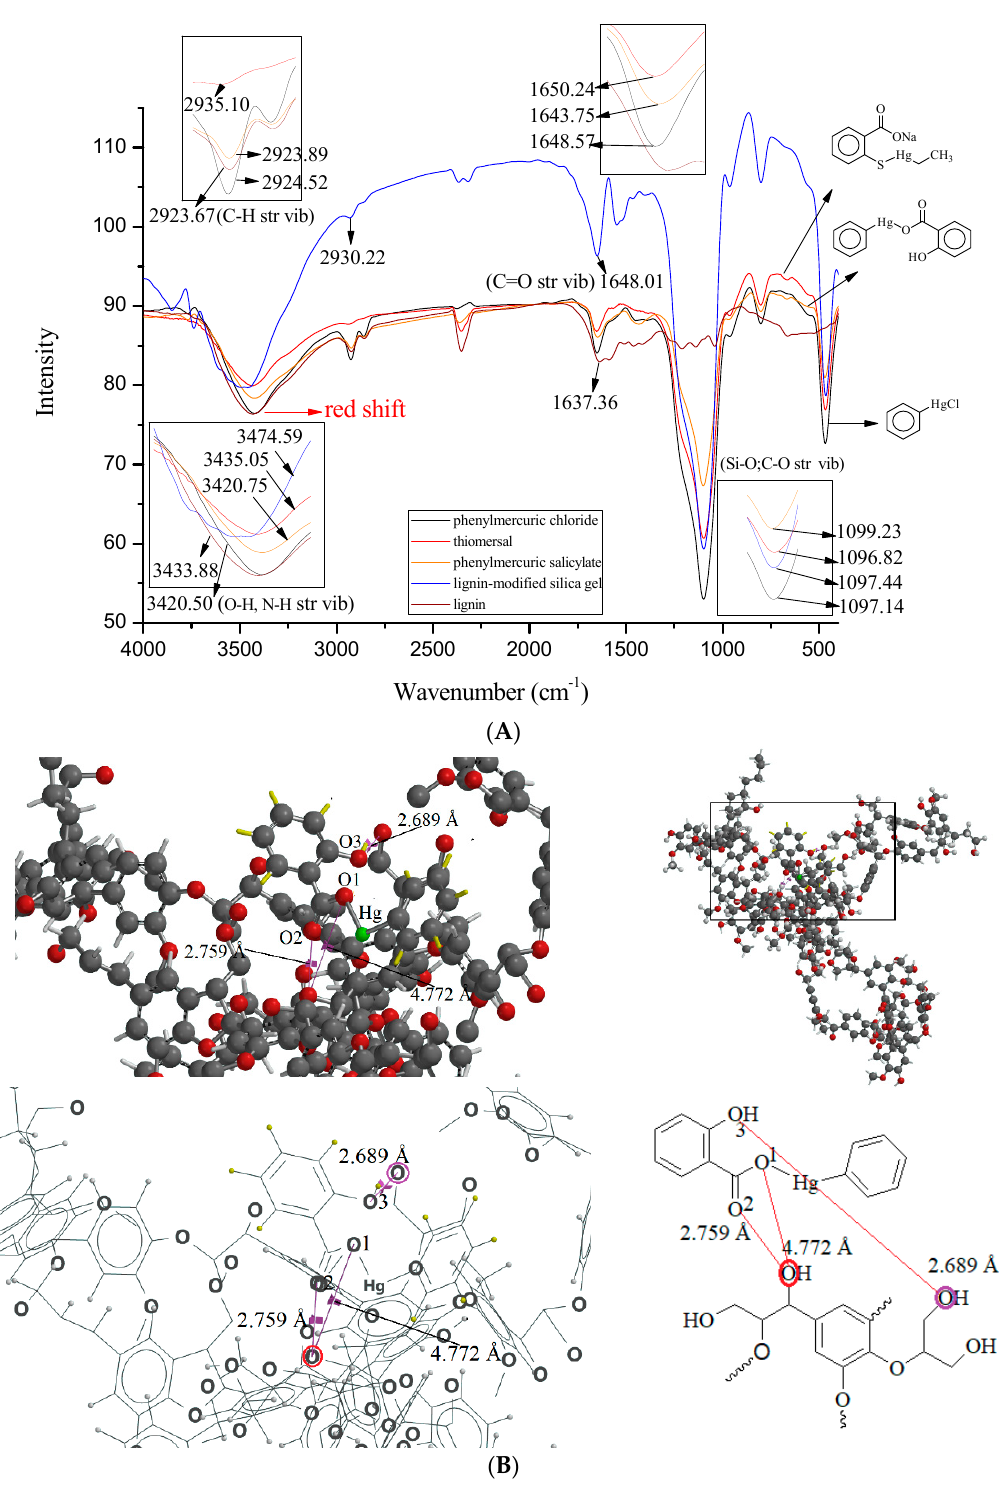
Figure 4. The superimposed FTIR spectra of phenylmercuric salicylate, thiomersal, phenyl mercuric chloride, lignin and lignin-modified silica gel for easy, quick reference and comparison ( A ), and the theoretical interaction simulation between lignin and phenylmercuric salicylate ( B ) after the energy minimization. Note that the hydrogen atom of the analyte in the 3D structure drawing is in yellow for easier distinction. The colored oxygen atoms, interacting with the carboxylate and hydroxyl groups of analyte on the lignin molecule, can be better viewed on a 2D structure drawing on the right.